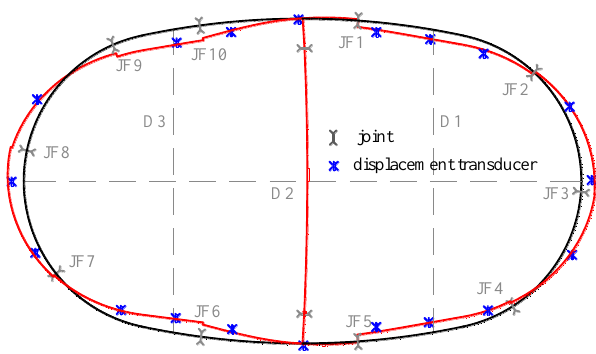
Figure 11. Measured deformations from experiment and numerical model in Experimental Case 1.